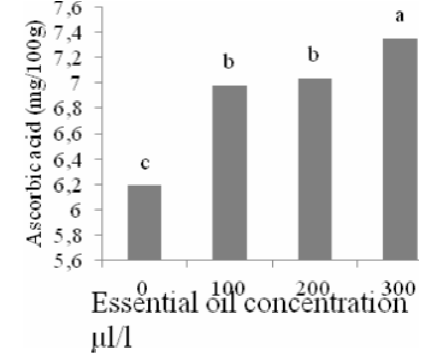
Fig. 6. The effect of basil essential oil treatment on ascorbic acid of ‘Golden Drop’